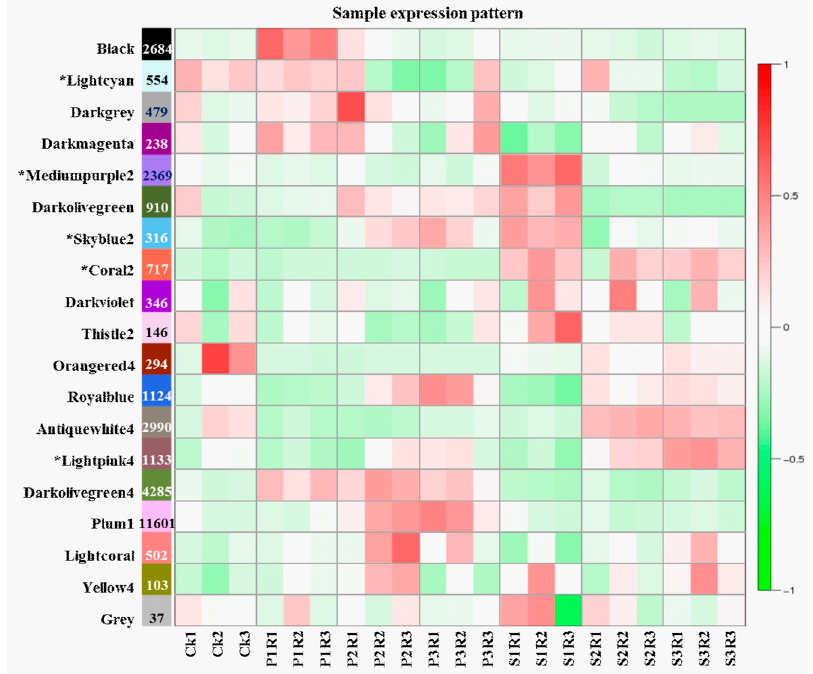
Figure 4. Weighted gene co-expression network analysis of genes in Pst - and Bgt -infected wheat young leaves tissues. The expressed genes were clustered into 18 modules labeled by different colors (not gray). Each row corresponds to one module. The number of genes in each module is indicated on the left. Each column corresponds to a specific sample. The color of each cell at the row-column intersection indicates the correlation coefficient between the module and the sample. The value of the correlation between a specific module and sample is indicated by the scale bar on the right. The letter P and S in X-axis referred to the Bgt and Pst stress respectively, while the following number 1, 2, and 3 represent the samples collected at 24, 48, and 72 hpi after inoculation. Similarly, R1, R2, and R3 mean the replications and sample number. The specific modules of wheat responding to Pst are marked with an asterisk.